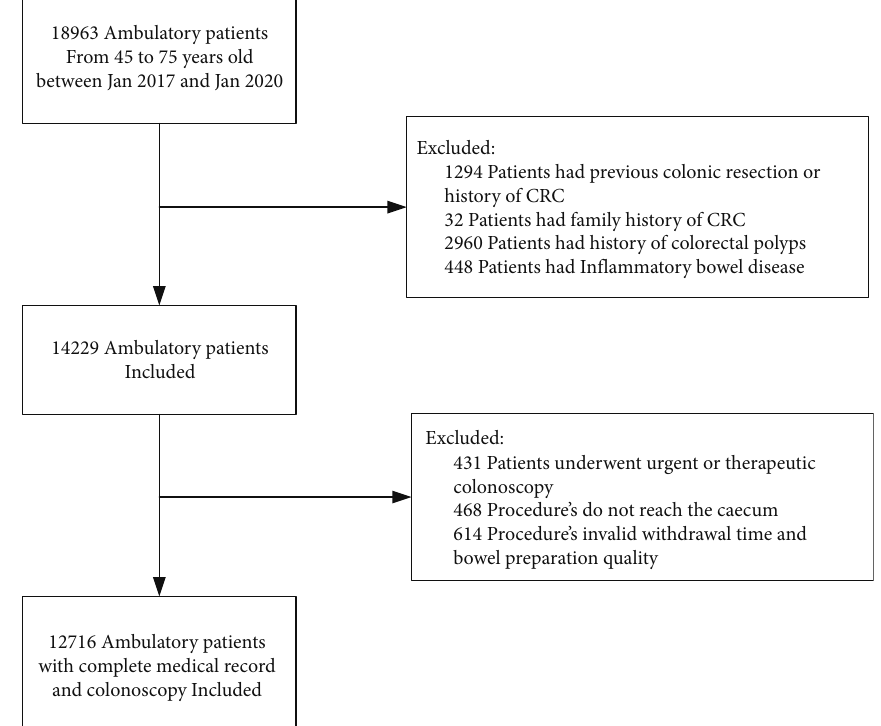
Figure 1: Flow chart for inclusion and exclusion of